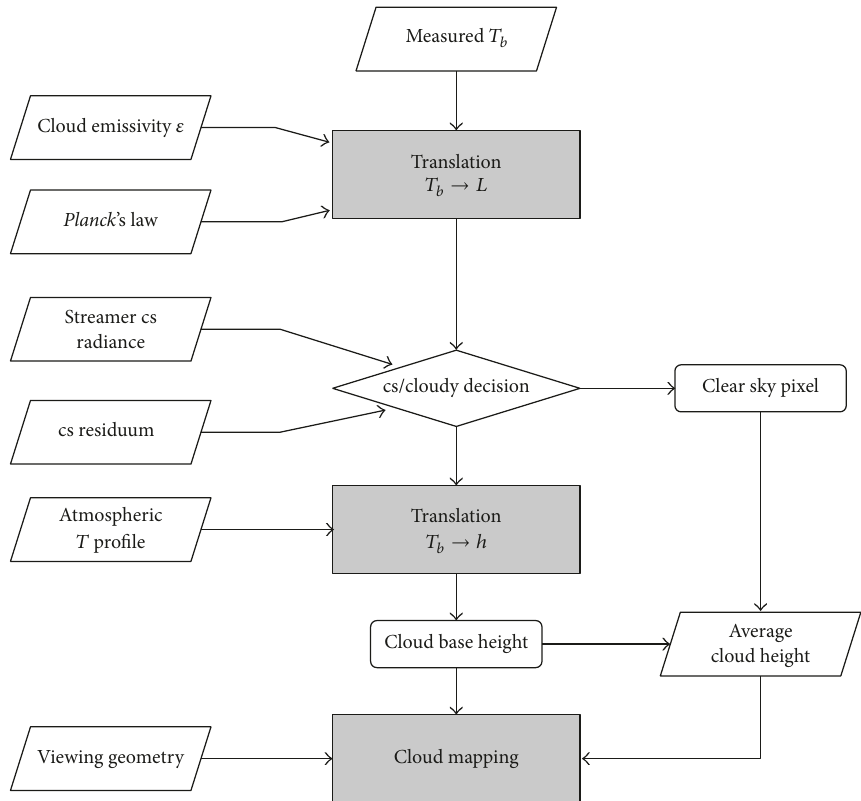
Figure 1: Flowchart of the cloud-base height determination for one single sterical pixel ( 𝑇 𝑏 = brightness temperature, 𝐿 = spectral radiance, cs = cloudless sky, ℎ = cloud-base height, and 𝑧 = zenith angle) (see text for